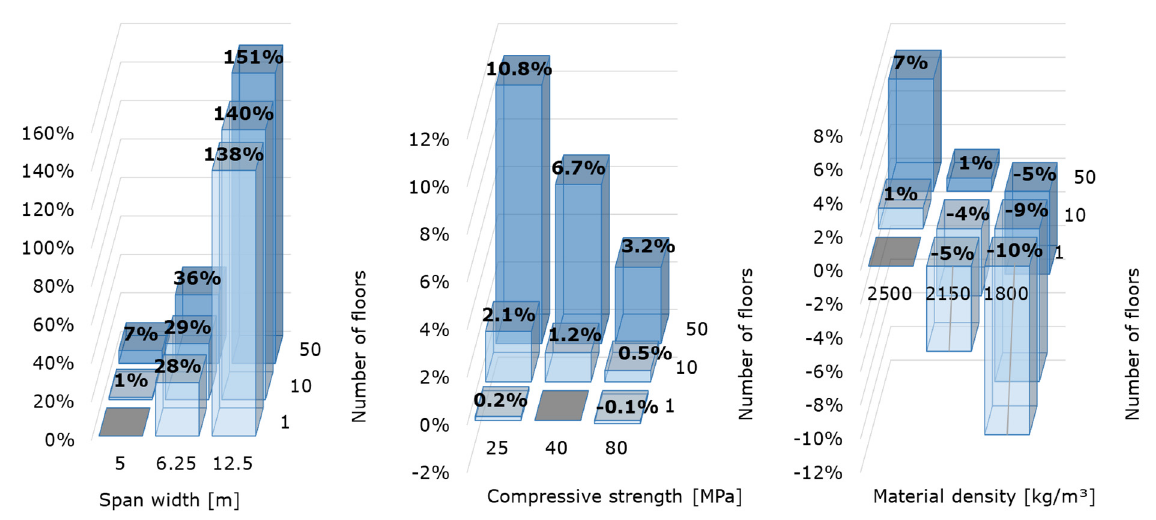
Figure 3. Percentage of additional or less material demand relative to a reference single storey structure (span = 5 m,  = 2500 kg/m³, q = 2 kN/m²,  = 40 MPa) depending upon number of stacked storeys, and parameter changes of the span width, the compressive strength, and material